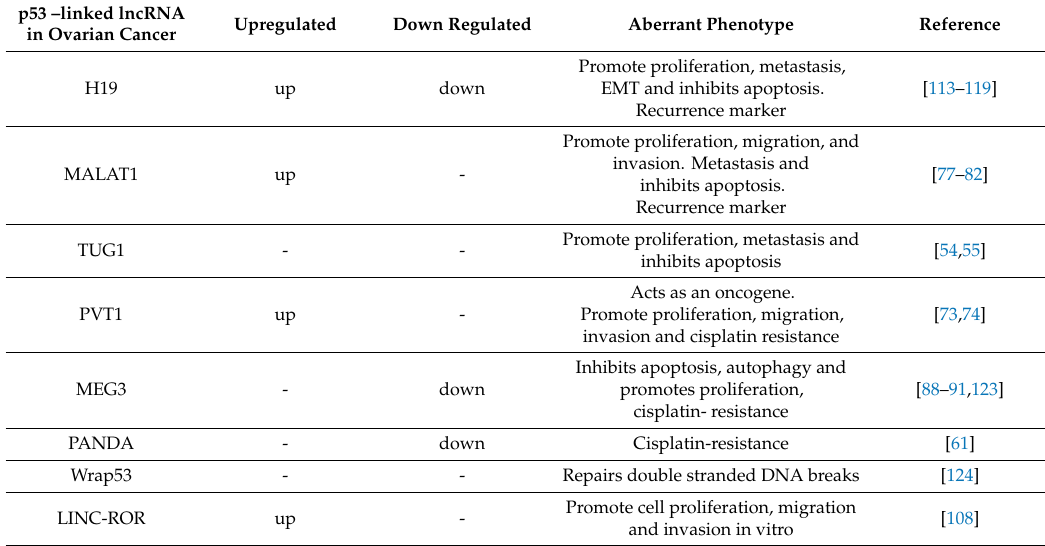
Table 1. Elucidating the role of various p53 linked lncRNAs in ovarian